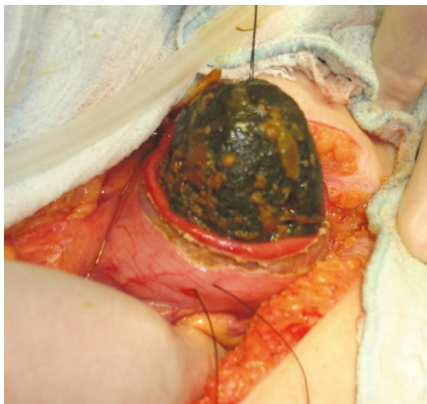
Figure 2: Intraoperative view; removing phytobezoar with gastro- tomy.